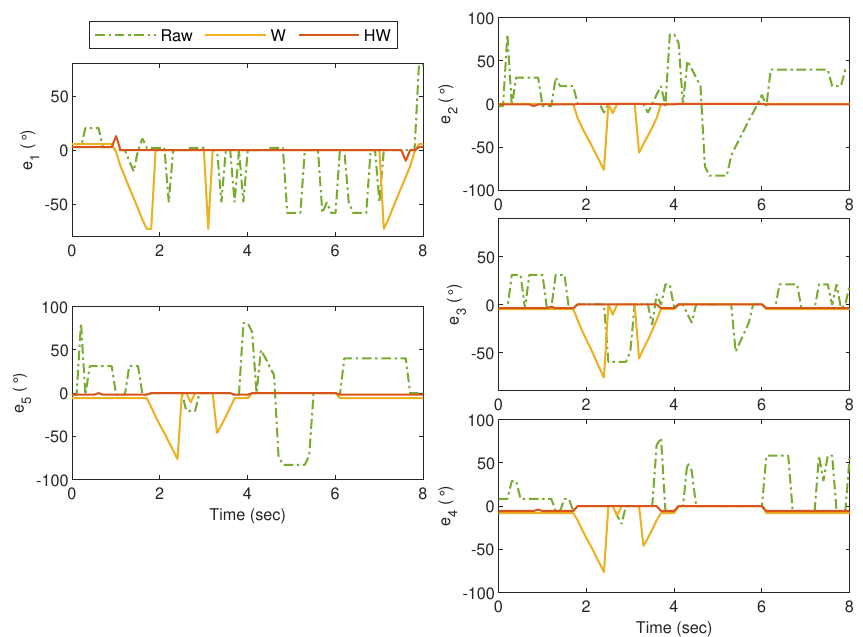
Figure 22. Gesture 5: The corresponding error from the response in Figure 21. The error due to the response from Compensator HW is the least at all time instances as compared to the others.